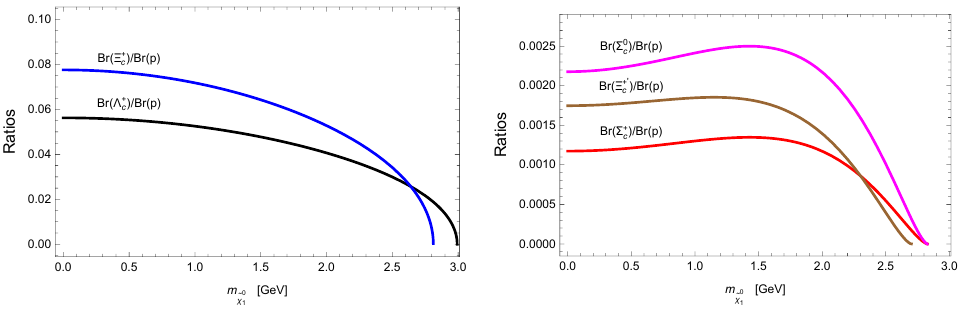
Figure 4 . Ratios of branching fractions for B → B ˜ χ 0 of B + → p ˜ χ 0 , for (top) the dominant modes with antisymmetric light-quark configurations and 1 (bottom) the suppressed modes with symmetric light-quark